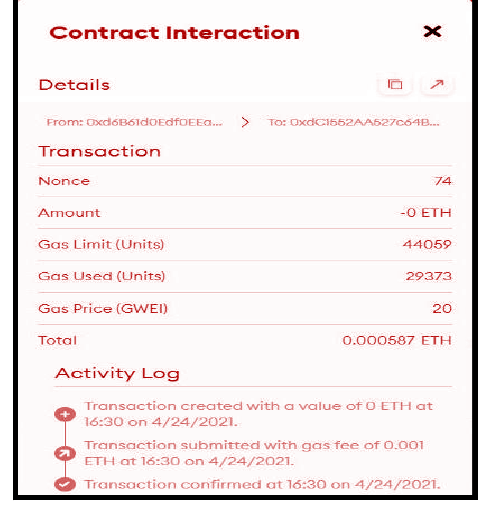
Figure 5. Metamask Wallet Transaction Details